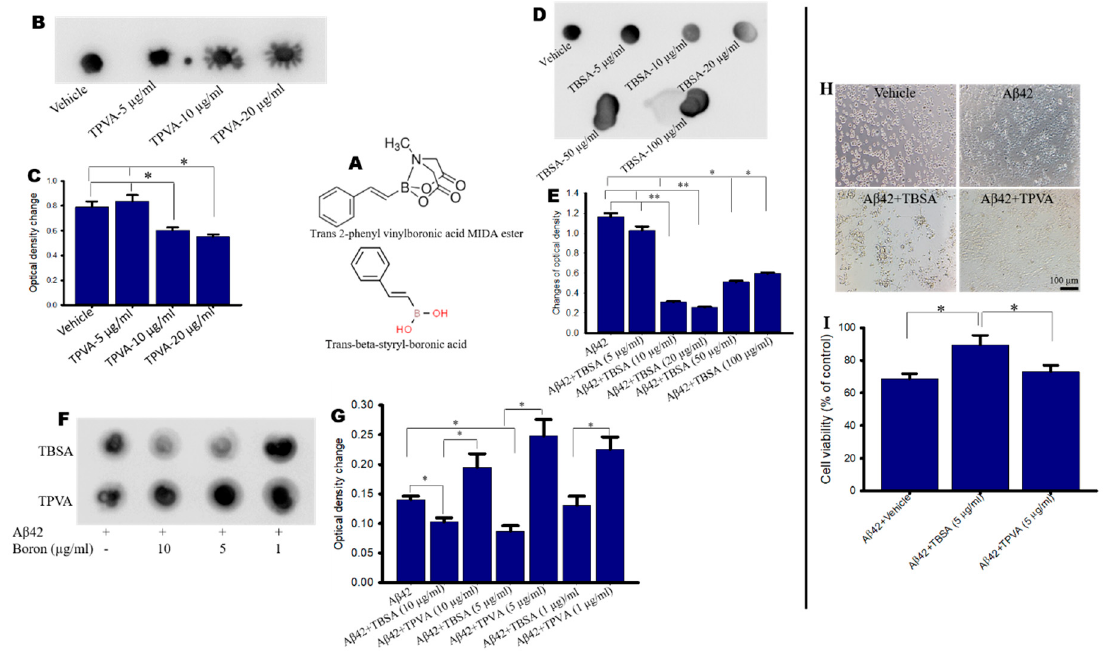
Figure 1. Effects of boronic compounds on A β 42 aggregation and neurotoxicity in vitro. ( A ): structural comparison of two different boron compounds, TPVA and TBSA. ( B – G ): Synthesized A β 42 (10 µM) was disaggregated with hexafluoroisopropanol and dissolved in phosphate buffer saline (PBS, 0.1M, pH 7.4) and allowed to aggregate in presence or absence of different concentrations of trans 2-phenyl vinyl-boronic acid (TPVA) MIDA ester and trans-beta-styryl-boronic acid (TBSA) for 24 h, after which